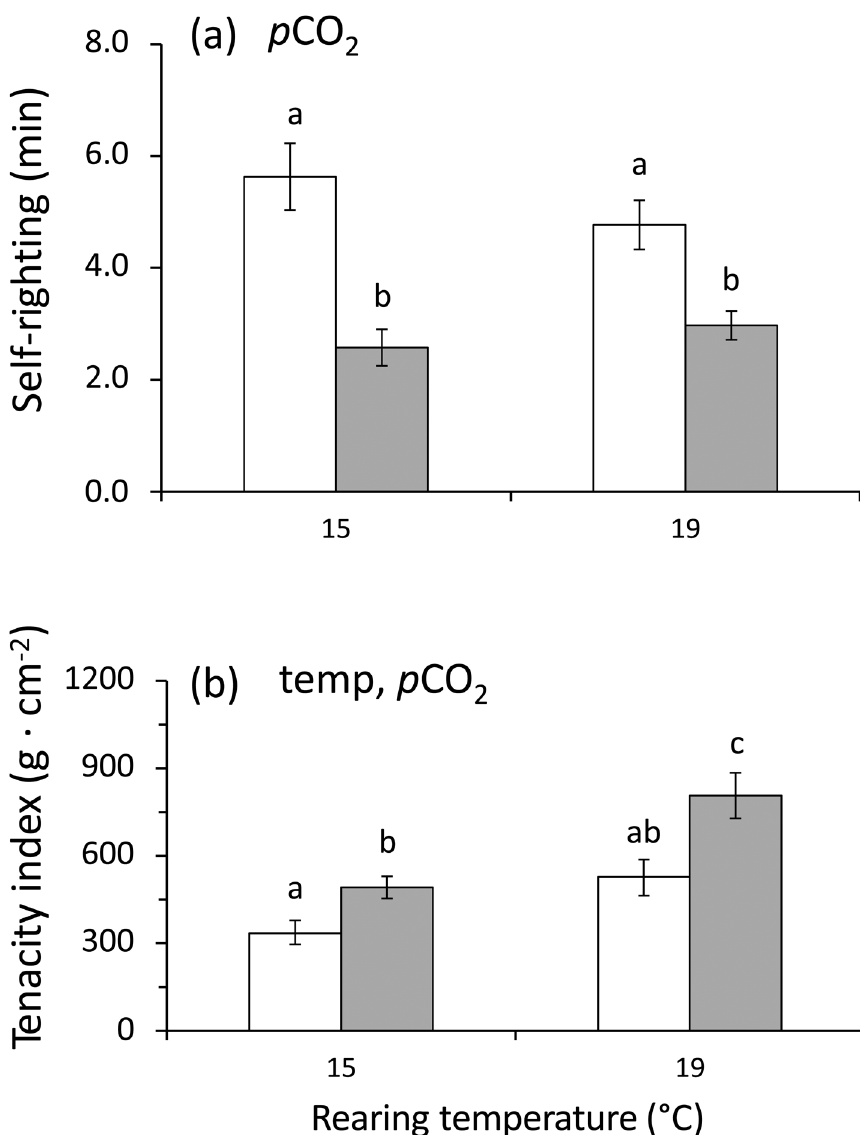
Fig 3. Concholepas concholepas. Effect of two different levels of p CO 2 and temperature on the (mean ± SE) (a) self-righting time and (b) force required to dislodge small juvenile individuals reared for 4 months in the experimental conditions. For each panel, the designations ‘ temp ’ and ‘ p CO 2 ’ indicate significant temperature or p CO 2 (2-way ANOVA). Open and filled bars represent measurements at current- day and high p CO 2 levels respectively. Different letters above the bars indicate significant differences (p < 0.05) in Tukey's HSD post hoc test on the 2-way ANOVA